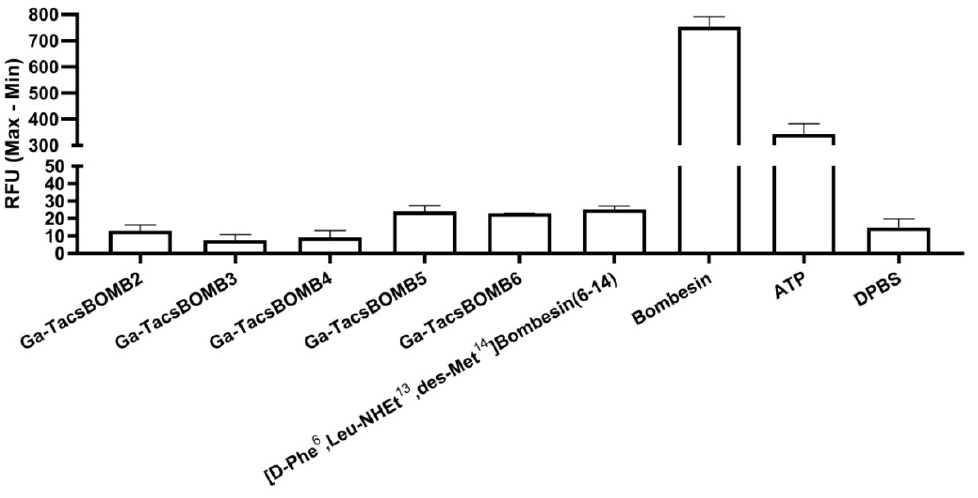
Figure 3. Intracellular calcium efflux in PC-3 cells induced by various tested ligands. Error bars indicate standard deviation.